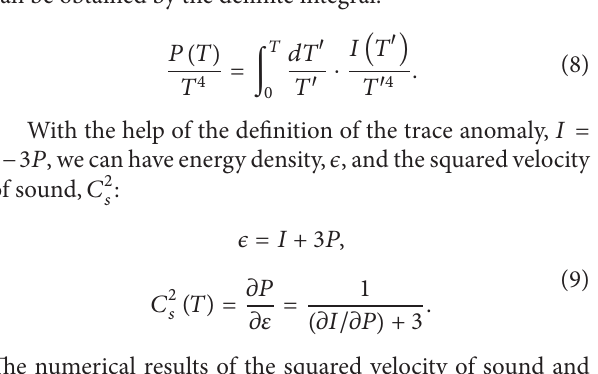
Figure 2. From this parametrization the normalized